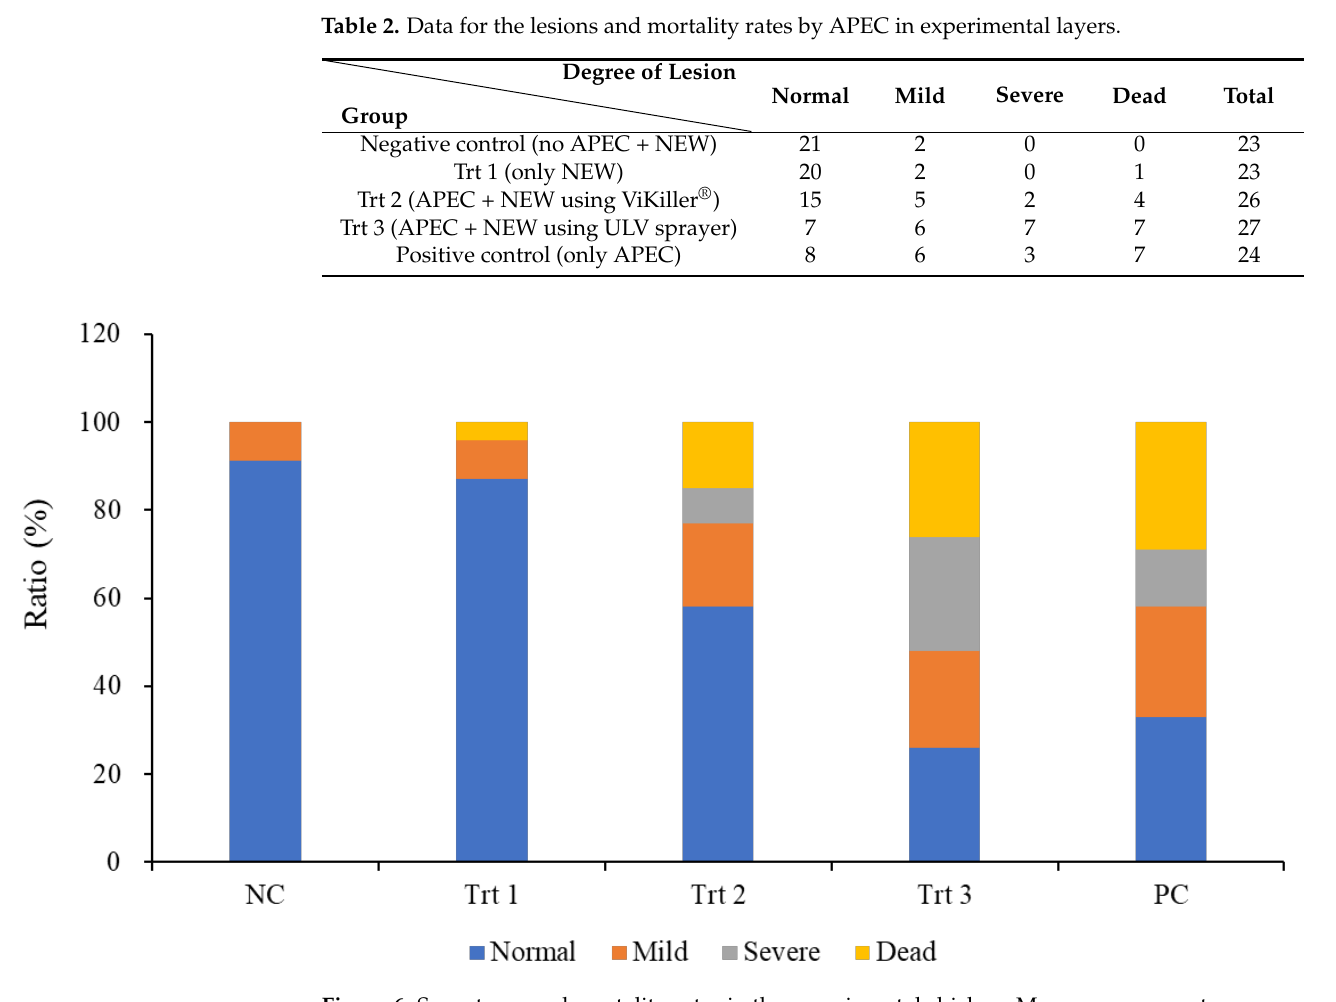
Figure 6. Symptoms and mortality rates in the experimental chicken. More severe symptoms were found in Trt 3 and PC groups. APEC also caused relatively higher death rates in the groups. Death rates and severe symptoms in Trt 2 were much lower than in Trt 3 and PC groups.